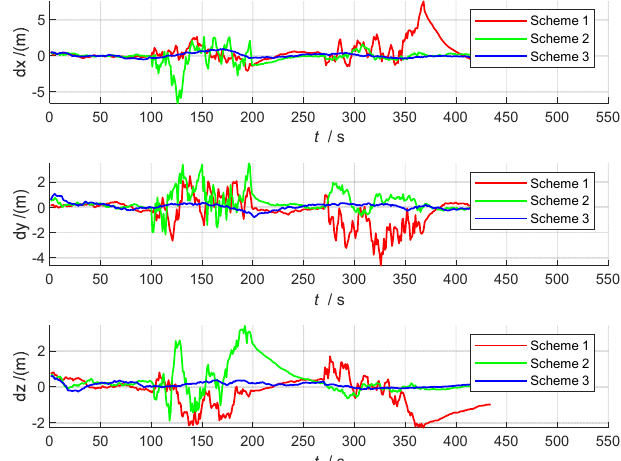
Figure 8. Comparison of position errors.